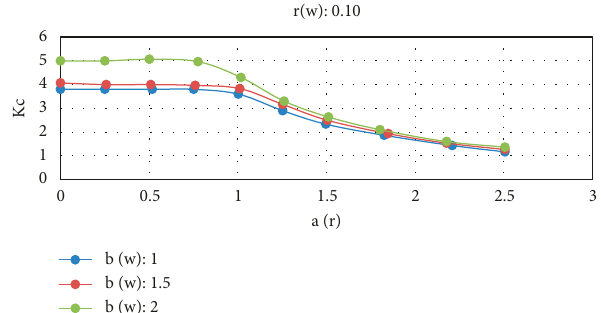
Figure 30: Dimensionless figure of tension coefficient according to crack length to radius ratios and different length to width for cavity with 0/1 ratio.